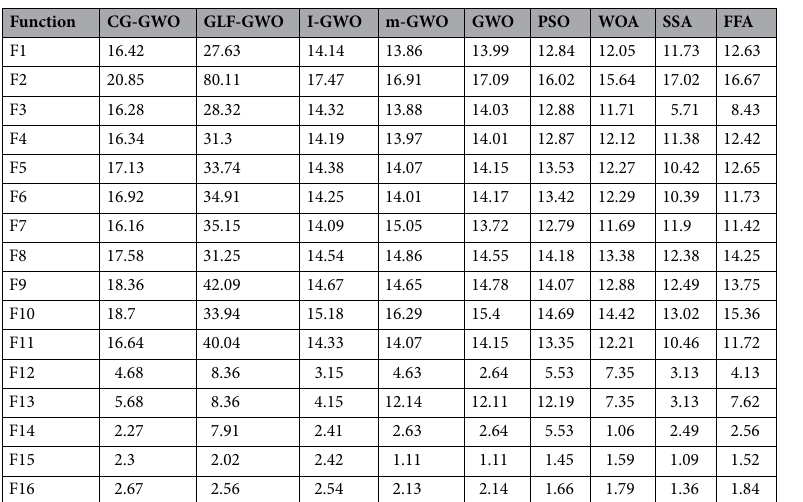
Table 7. Experimental results comparison of algorithm